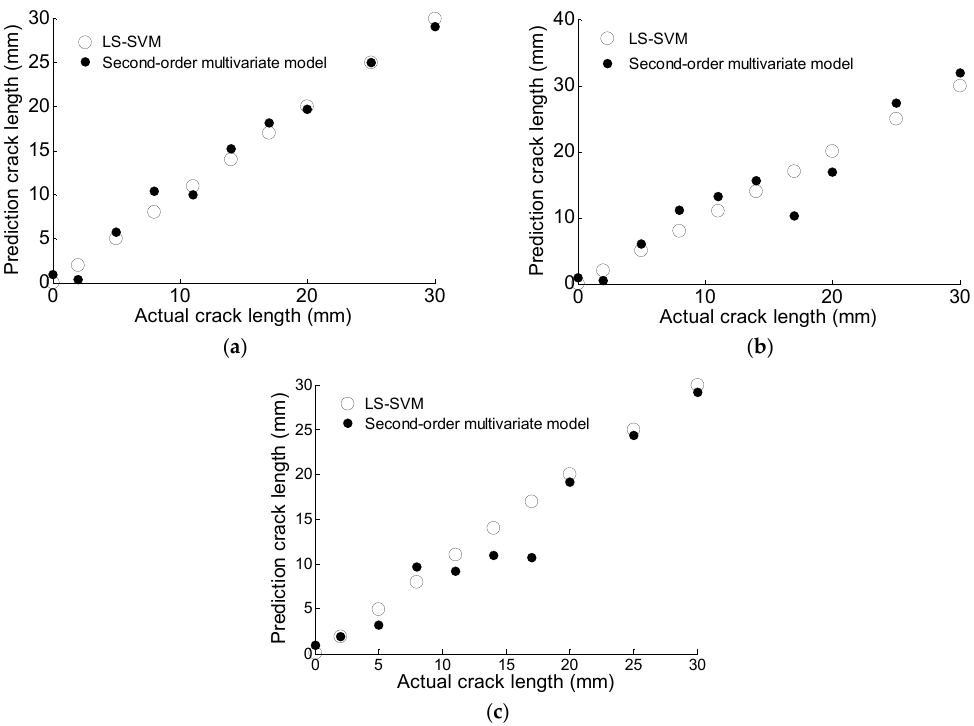
Figure 15. The comparison of prediction data based on second-order multivariate model and GA based Table 4. The regression parameters for the second-order multivariate model.